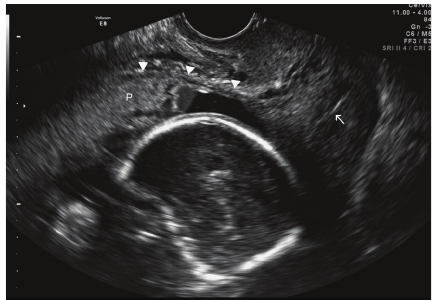
Figure 2: Sagittal transvaginal sonogram performed 3 months later shows intrauterine pregnancy with 19-week sized fetus. Thinned lower anterior uterine wall (arrowheads) and contiguous placenta (P) are suspicious for placenta accreta (arrow: cervical